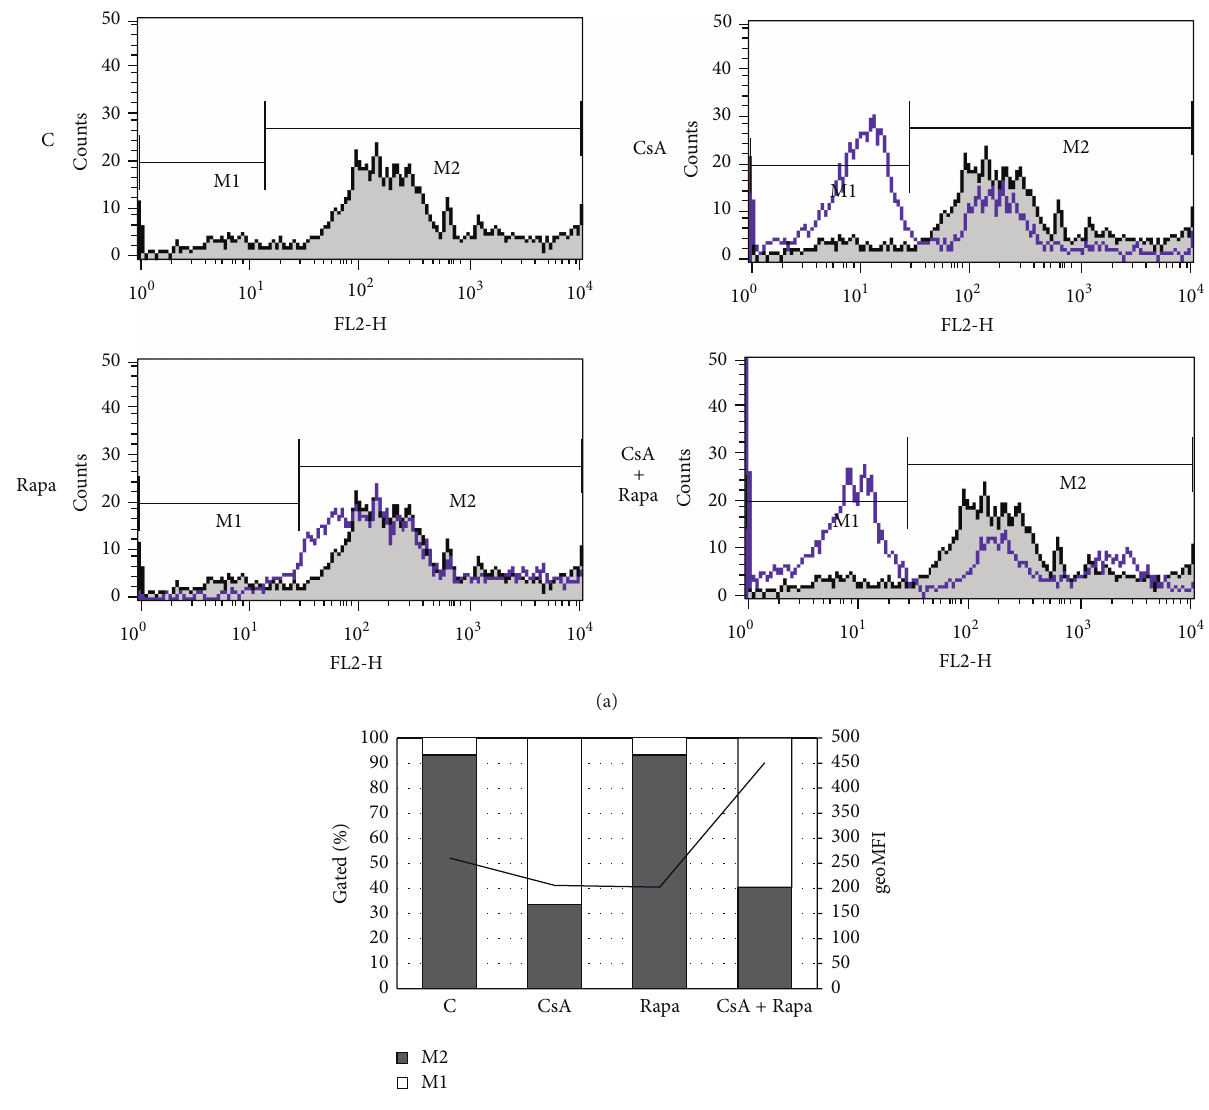
Figure1:Immunosuppressivedrugsalterthesurfaceexpressionofhigh-mannose/hybridN-glycans.Peripheralbloodmononuclearcellswere cultured for 6 days in the presence of CsA (200ng per 1mL medium), Rapa (20 ng per 1mL medium), and the combination of CsA (150ng per 1mL medium) and Rapa (12ng per 1mL medium) in a two-way mixed leukocyte reaction (MLR). Immunosuppressive drug-treated and control cells were stained with biotinylated GNA (1: 100), followed by incubation with FITC-conjugated ExtrAvidin. M2 region corresponds to GNA-positive leukocytes after allostimulation. Fluorescence was measured using a FACSCalibur flow cytometer (BD Biosciences). C: untreated cells, CsA: cyclosporin A, and Rapa: